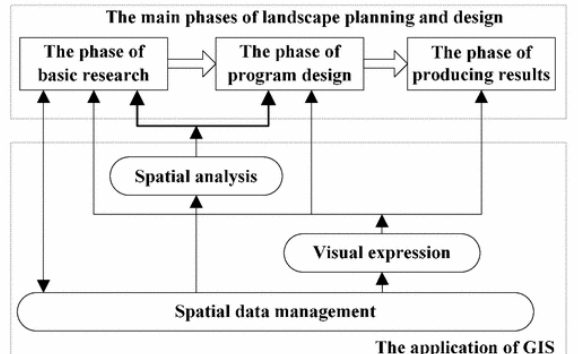
Figure 2 Main steps of landscape planning and design and their application in GIS (Xu,